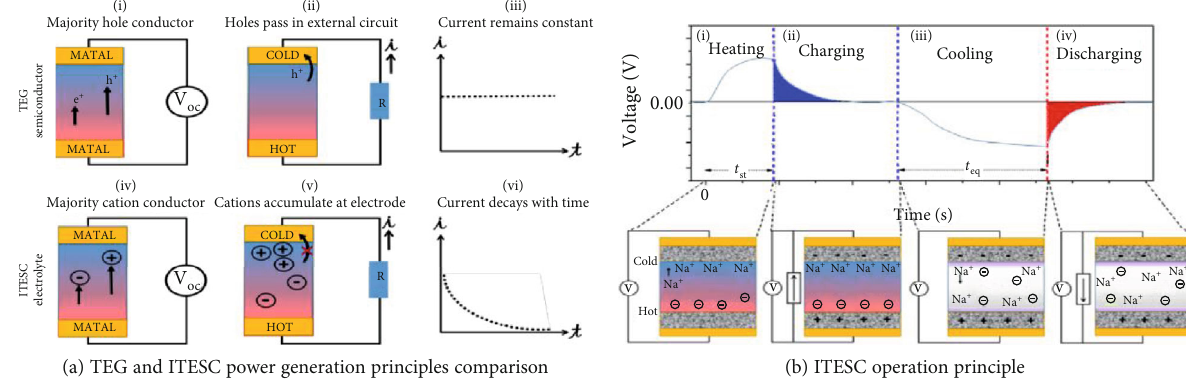
Figure 3: Ionic thermoelectric supercapacitor summary (adapted from